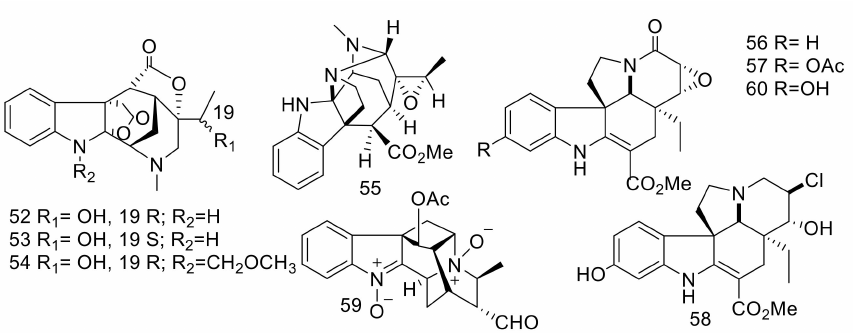
Figure 9. Compounds 52 – 60